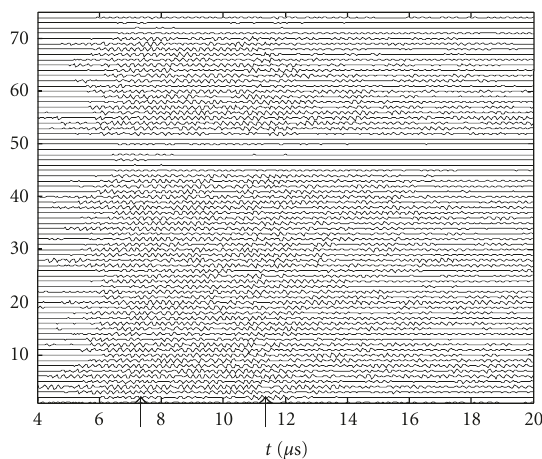
Figure 3: A portion of the original B-scan; the arrows indicate the delays where the trace of the mortar layer interface should be out-